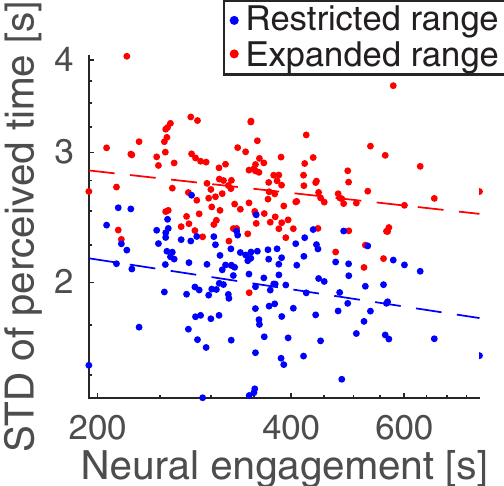
Figure 3. Engagement predicts the variability of time perception. Viewers estimated the duration of time intervals within each video. Each point represents a time interval in a video. ( a ) The duration of intervals with high neural engagement were perceived less variably across viewers (r = − 0.27, p = 0.0009, and r = − 0.23, p = 0.05, N = 129 intervals for all 10 videos, for restricted and expanded range, respectively). Comparisons are made across two independent cohorts who had either a restricted range (blue, 8–16 s) or expanded range (red, 4–20 s) available for their time duration estimates. All time measures are displayed on a perceptual log-seconds